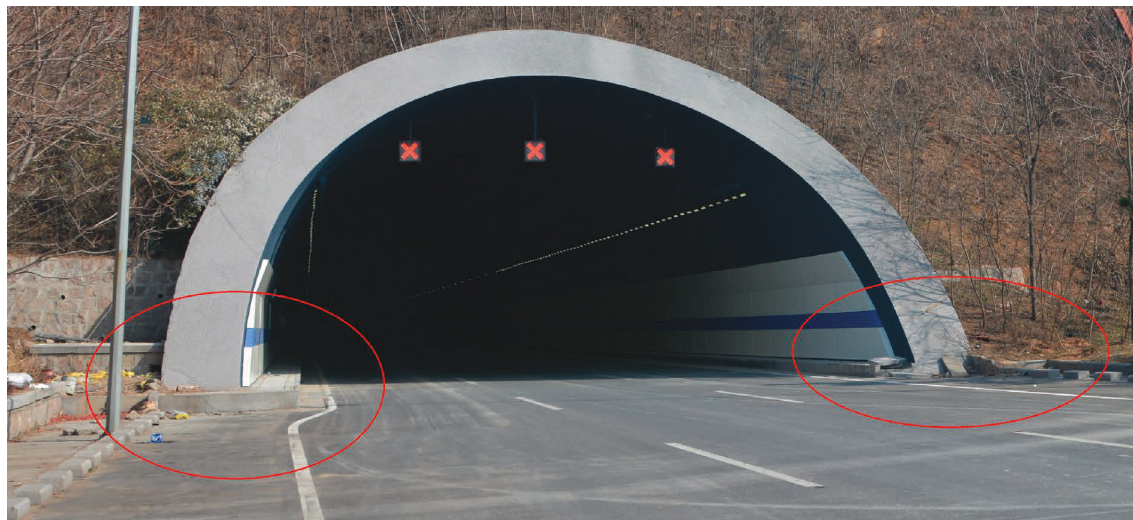
Figure 2: The narrowed cross section.